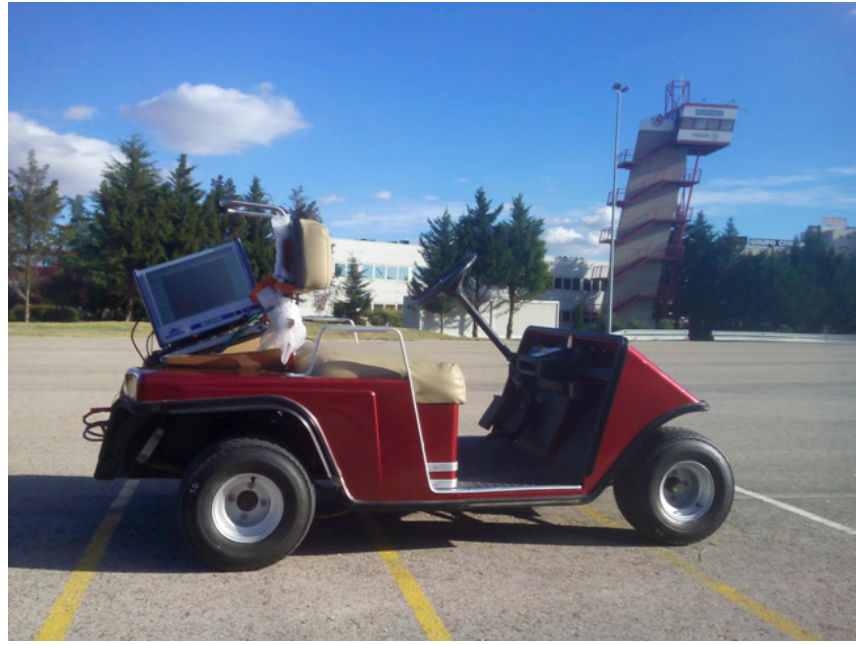
Figure 23. Acquiring of experimental data.